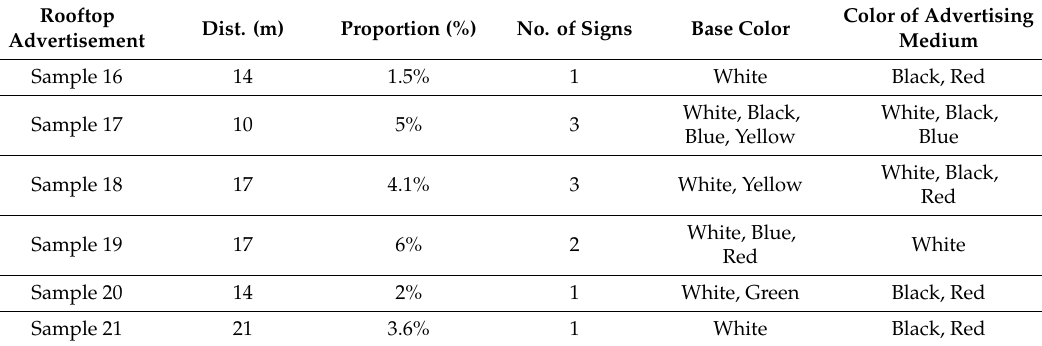
Table 2. Analysis of landscape samples of rooftop advertising signs.